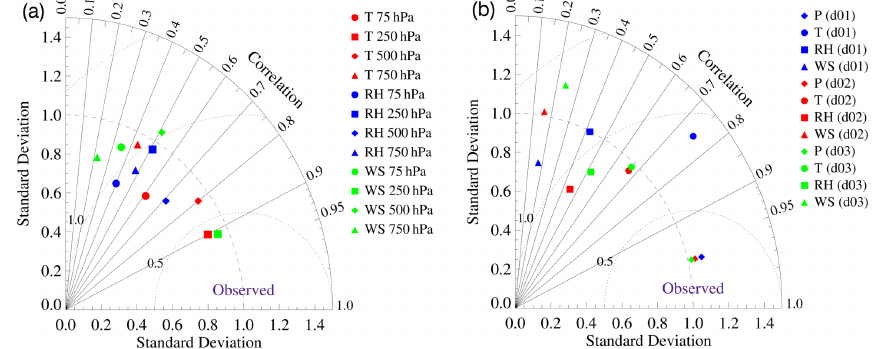
Figure 7. Taylor diagram with the correlation coefficient, normalized standard deviation, and normalized root mean square difference (RMSD) error for (a) model performance at the different pressure levels shown in Fig. 3 for d01. (b) The model-simulated surface pres- sure, 2m temperature, RH, and 10m wind speed for different domains as shown in Fig. 6a–c.